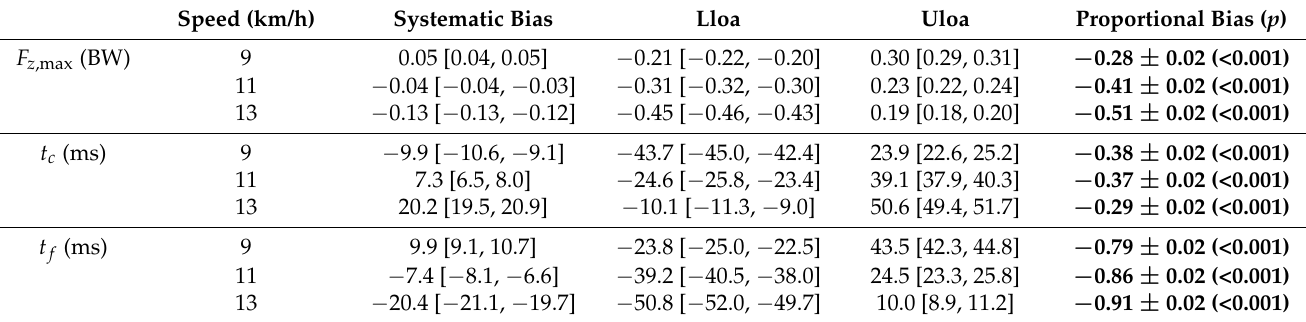
Table 1. Systematic bias, lower limit of agreement (Lloa), upper limit of agreement (Uloa), and proportional bias ± residual random error together with its corresponding p -value between peak vertical ground reaction force ( F z ,max ), contact time ( t c ), and flight time ( t f ) obtained using inertial measurement unit method and gold standard method at three running speeds. Confidence intervals of 95% are given in square brackets [lower, upper]. Significant ( p ≤ 0.05) proportional biases are reported in bold font.